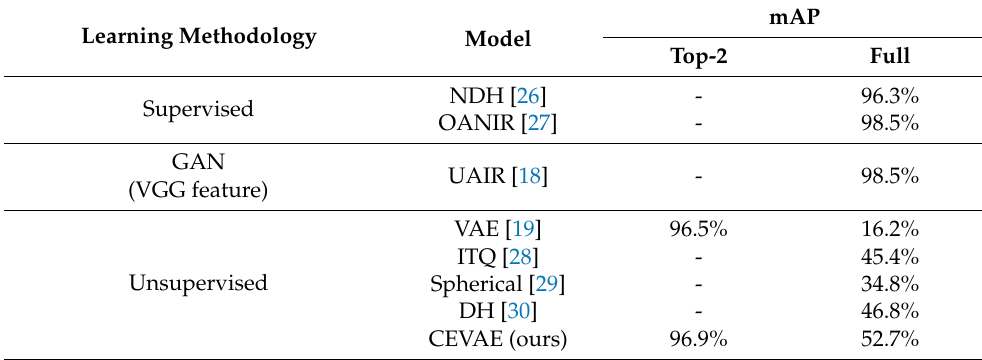
Table 4. Comparison performance of image